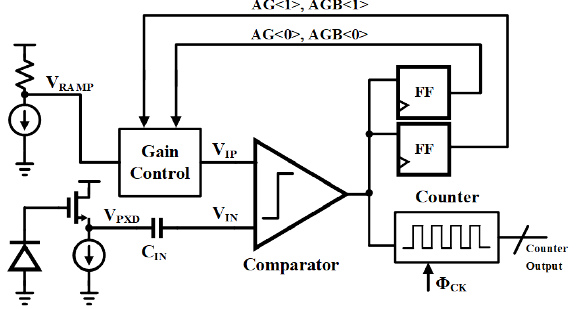
Figure 5. Block diagram of the proposed gain-adaptive